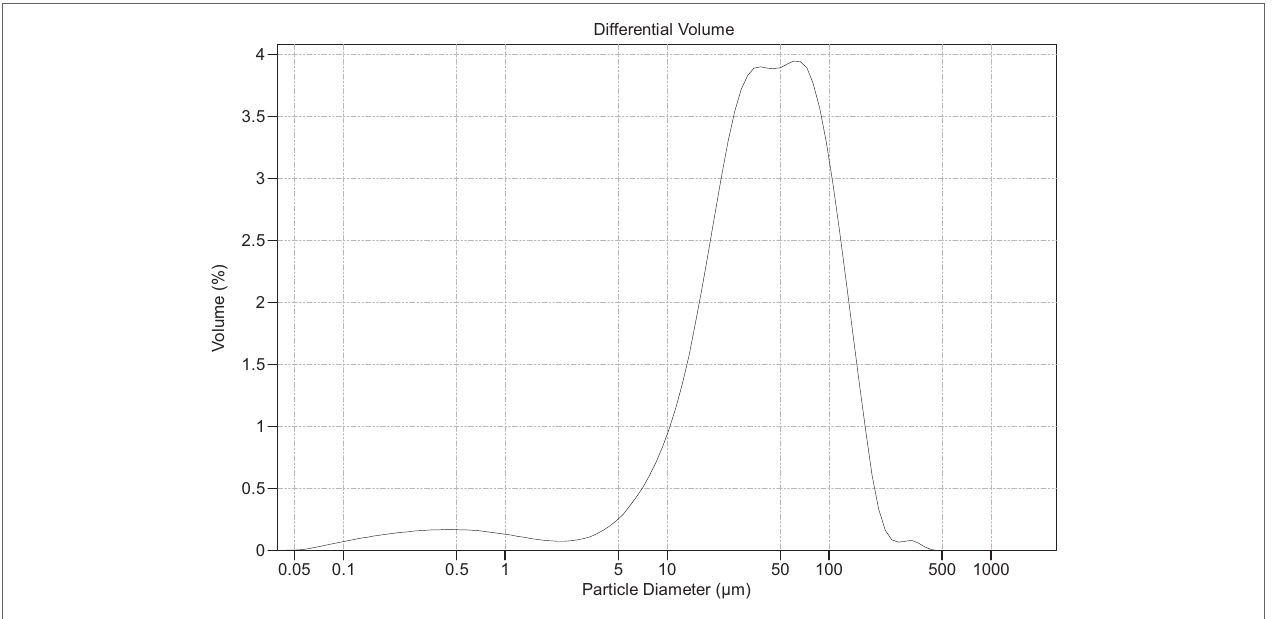
FigUre 5 | Particle size distribution of the solids in the calcite slurry .